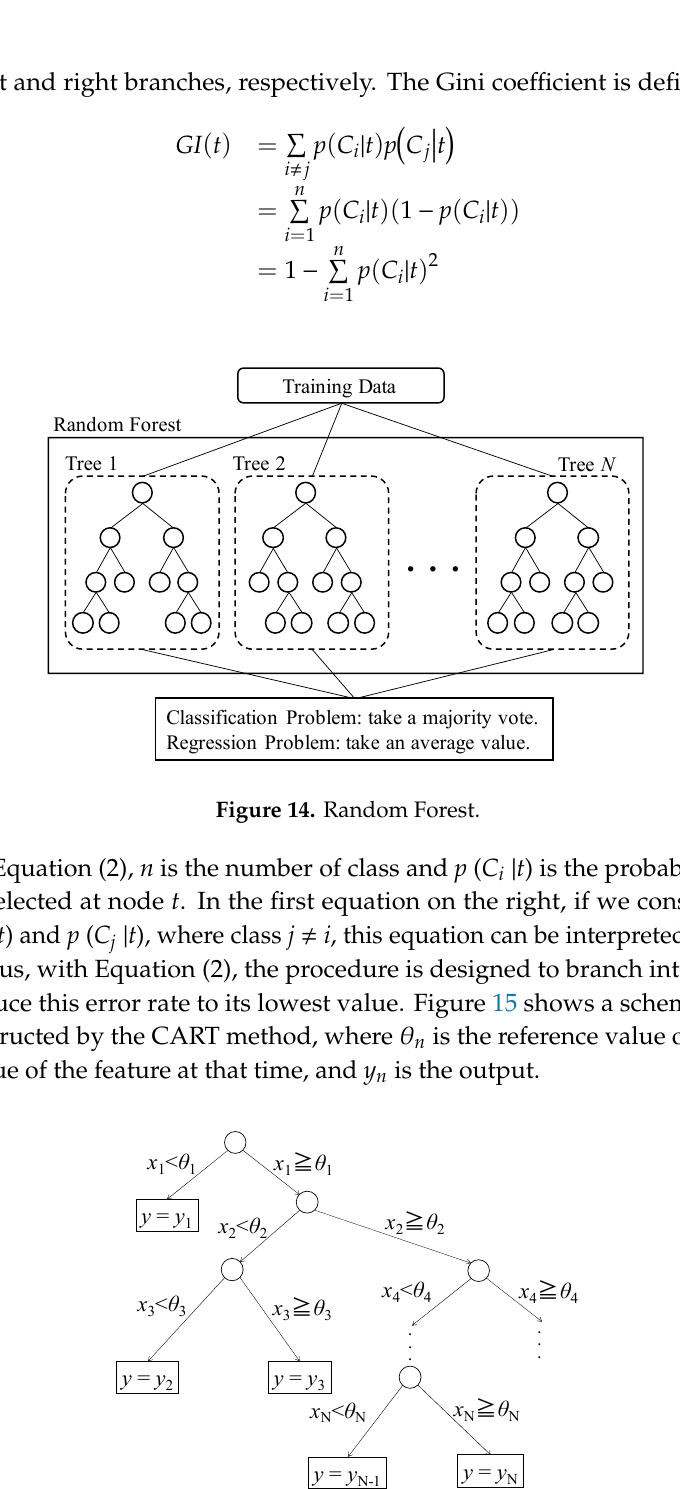
Figure 15. Schematic diagram of the decision tree.